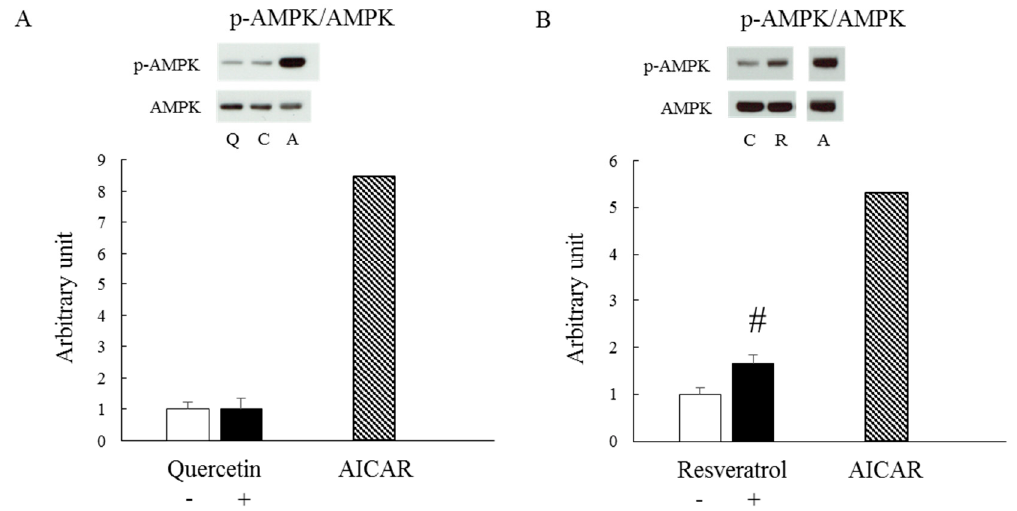
Figure 1. E ff ect of quercetin stimulation on AMPK phosphorylation in vitro. Isolated epitrochlearis muscles were incubated for 30 min either in the absence (-) or presence ( + ) of 100 µ M quercetin ( A ) or 100 µ M resveratrol ( B ). Values are means ± SE ( n = 4–5). Sample stimulated with 0.5 mM 5- aminoimidazole-4-carboxamide-1-beta-d-ribofuranoside (AICAR) was used as a positive control ( n = 1). A representative blot is shown above each figures. The obtained values of p-AMPK were normalized with the value for AMPK. # p < 0.05 vs. resveratrol (-). C: control (absence of stimulant), Q: quercetin, R: resveratrol, A: AICAR.